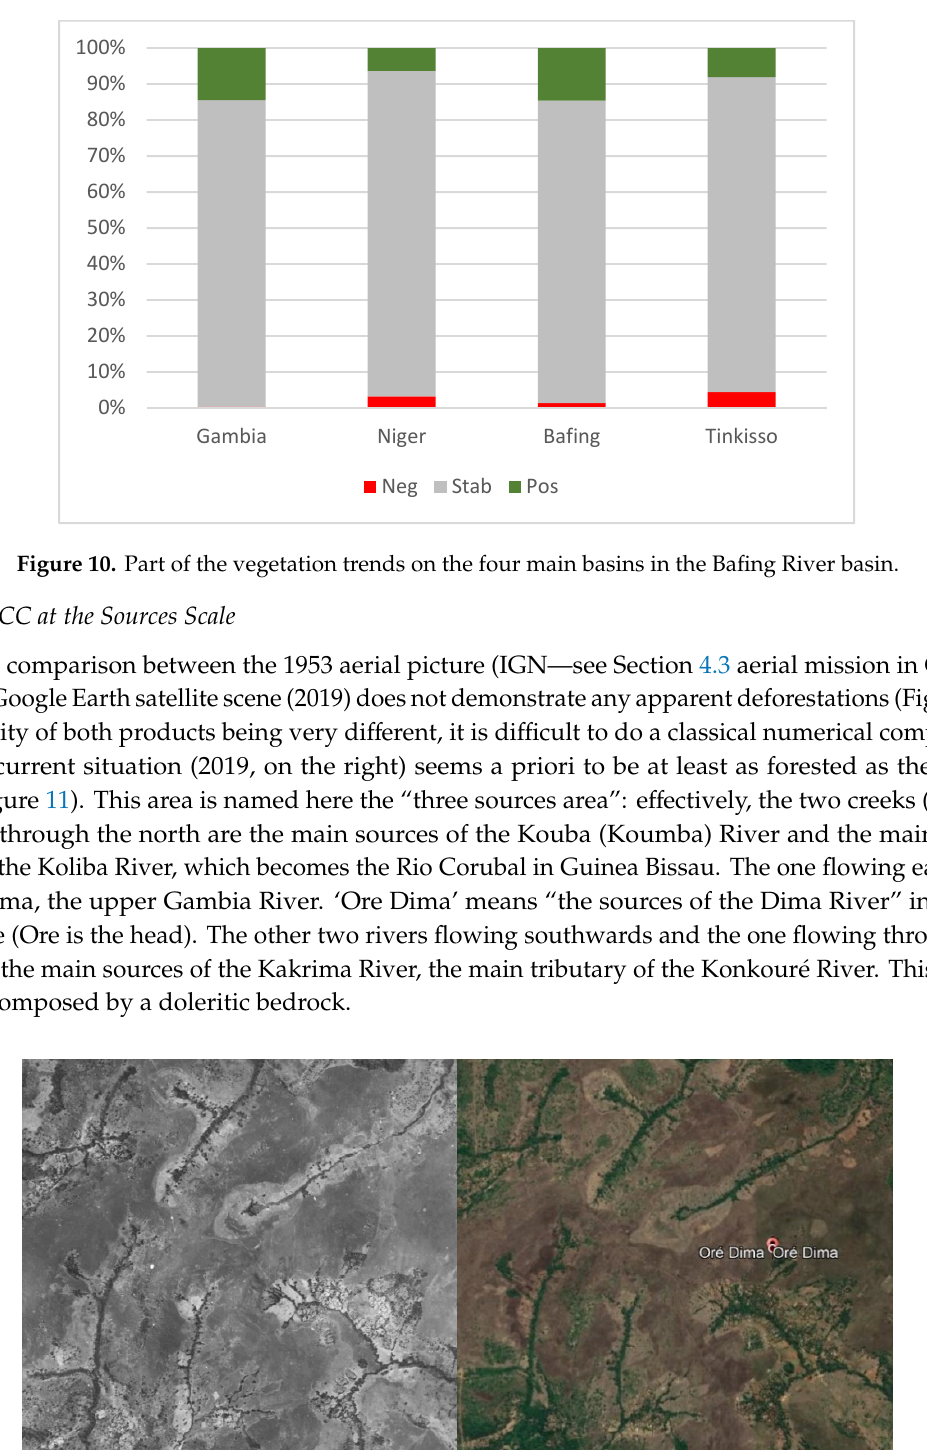
Figure 11. The so-called “three sources” area (15 km northward from Labé, the main city of the Fouta Djallon) in 1953 (IGN, left ) and in 2019 (Google Earth © , right ). No apparent deforestation. The extension of the picture is 5 km from the west to the east by 4.5 km from the north to the south. The area represented is the one of the red square in Figure 7.